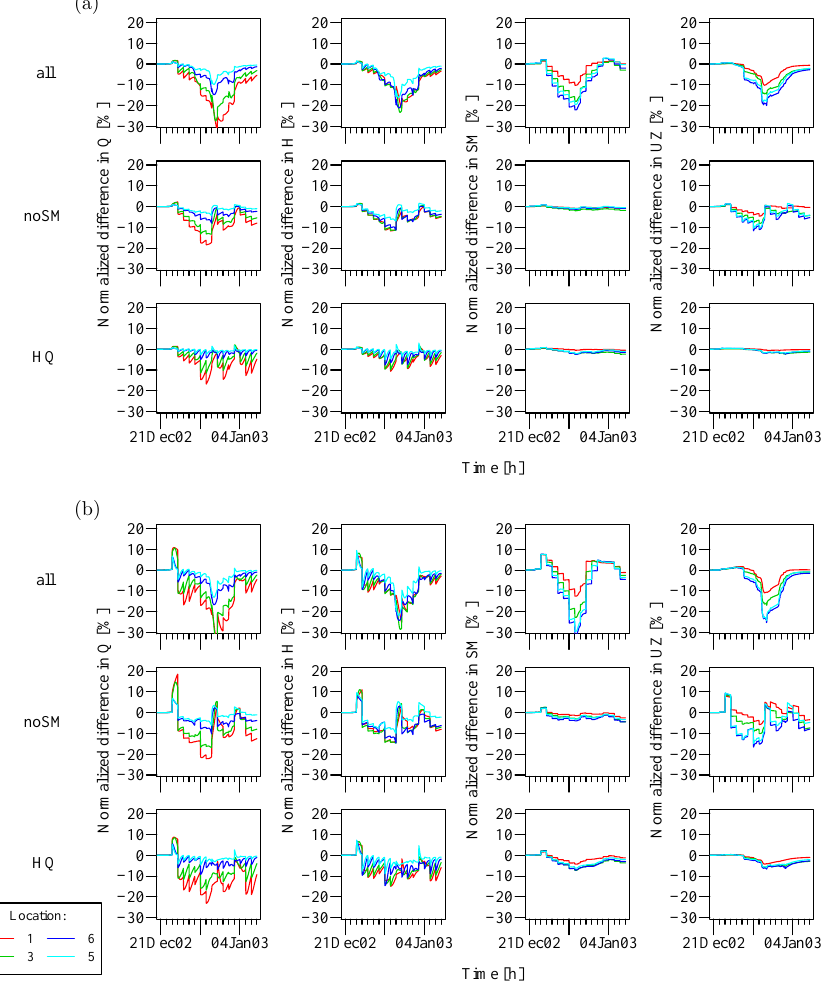
Figure 8. Scaled difference between the ensemble mean for the three partitioned update schemes and the control run without data assimilation at four gauging locations (shown by different colours) within the Upper Ourthe catchment using the AEnKF with (a) W = 0 and (b) W = 11. We excluded the insensitive lower zone (LZ). Gauges 1, 3, 5, and 6 are assimilated. The results correspond to the same period as presented in Fig.